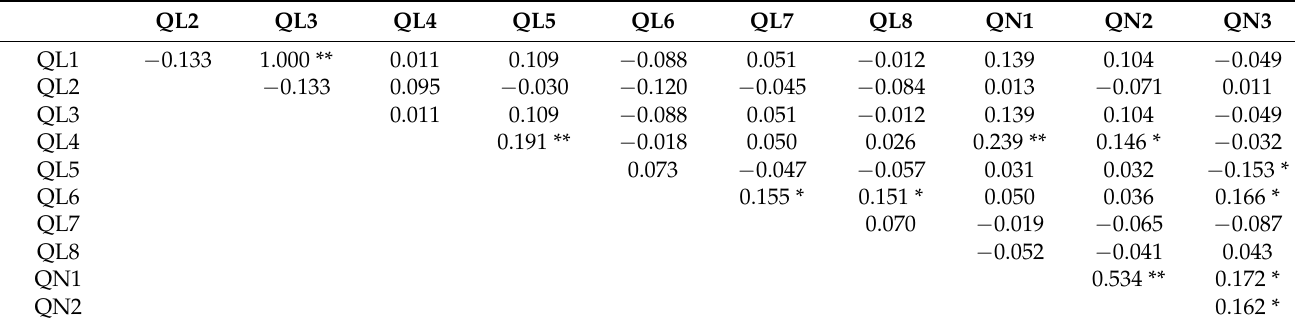
Table 1. Correlation coefficients among 11 qualitative and quantitative characters in 183 accessions of native Perilla frutescens var. frutescens of Perilla